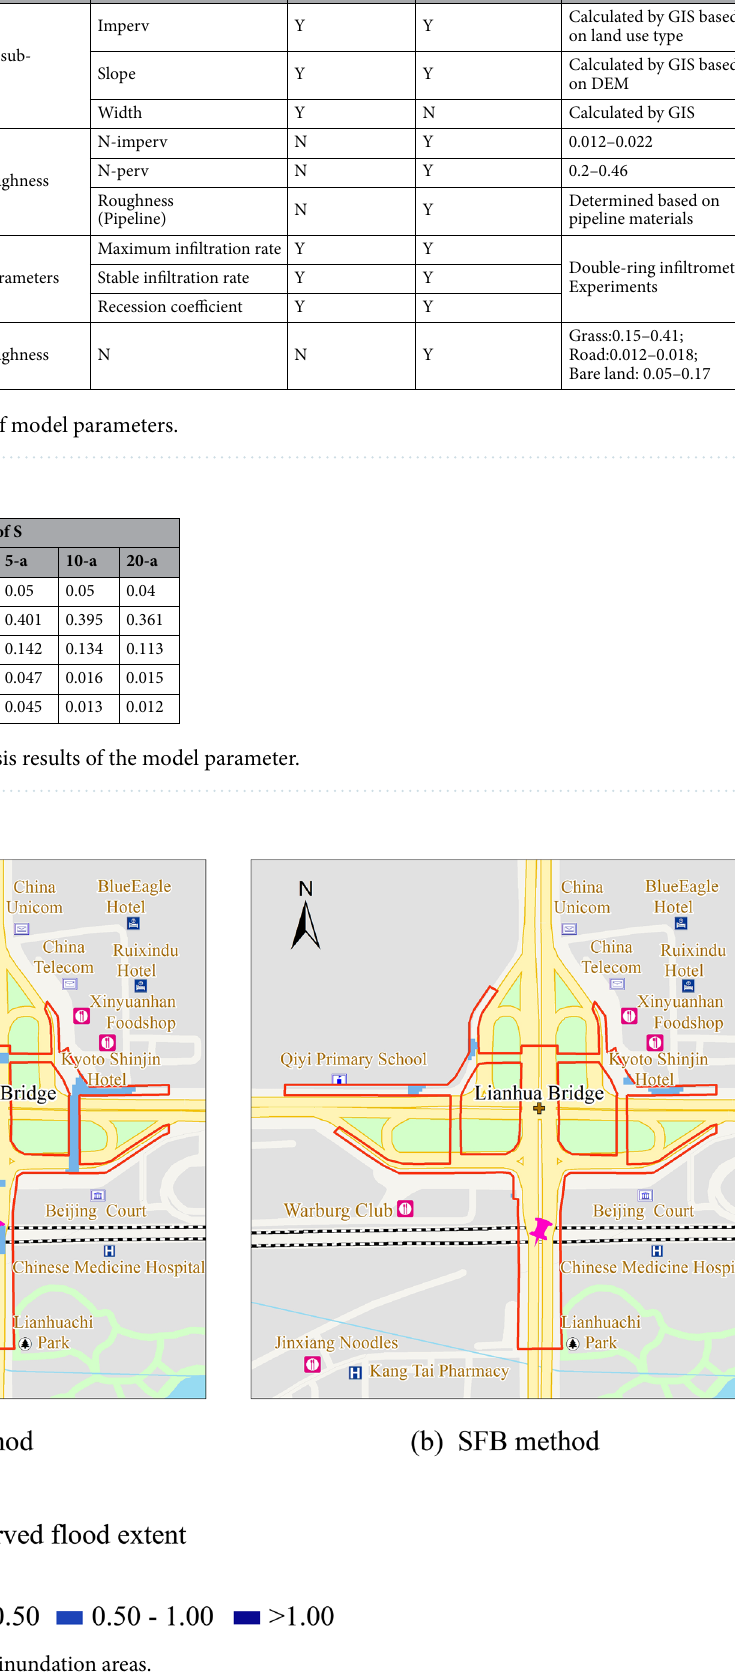
Figure 8. The SF method inundation